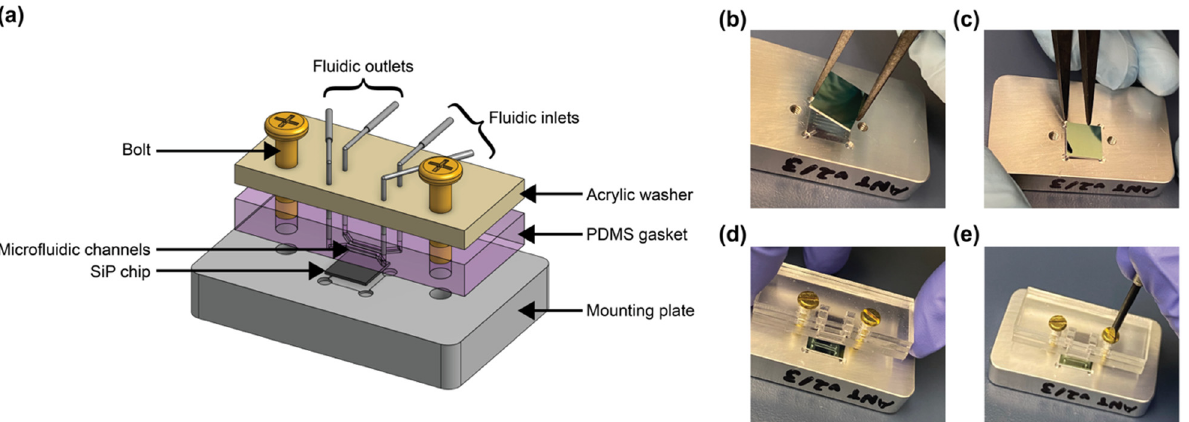
Figure 6. ( a ) Schematic and ( b – e ) photos of microfluidic and photonic chip assembly for fluidic testing. ( b ) The chip is placed on the mounting plate, ( c ) the chip is positioned into the machined recess of the mounting plate, ( d ) bolts are threaded through the bolt holes of the acrylic washer and poly(dimethylsiloxane) (PDMS) gasket and aligned to the threaded holes in the mounting plate, and ( e ) bolts are screwed into place to align and seal the fluidics against the photonic chip.